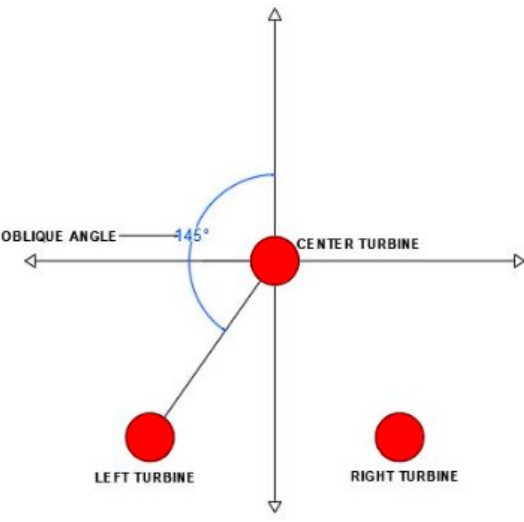
Figure 17. Oblique angle convention. Table 6. Coefficient of performance at different oblique angles.